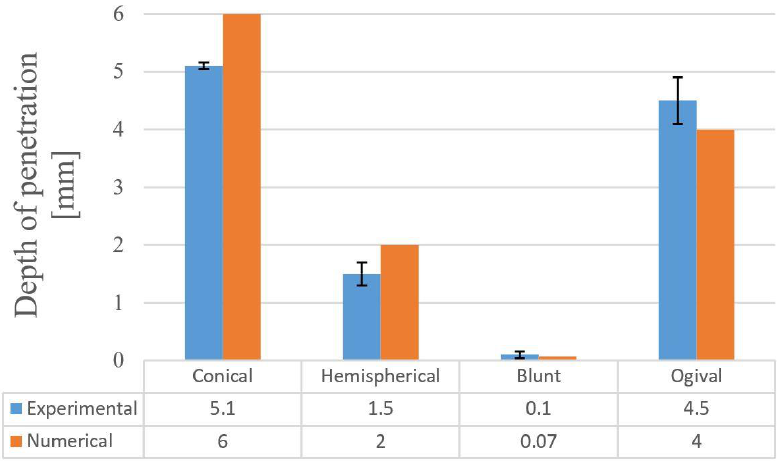
Figure 11. Comparison of depth of penetration after impact.